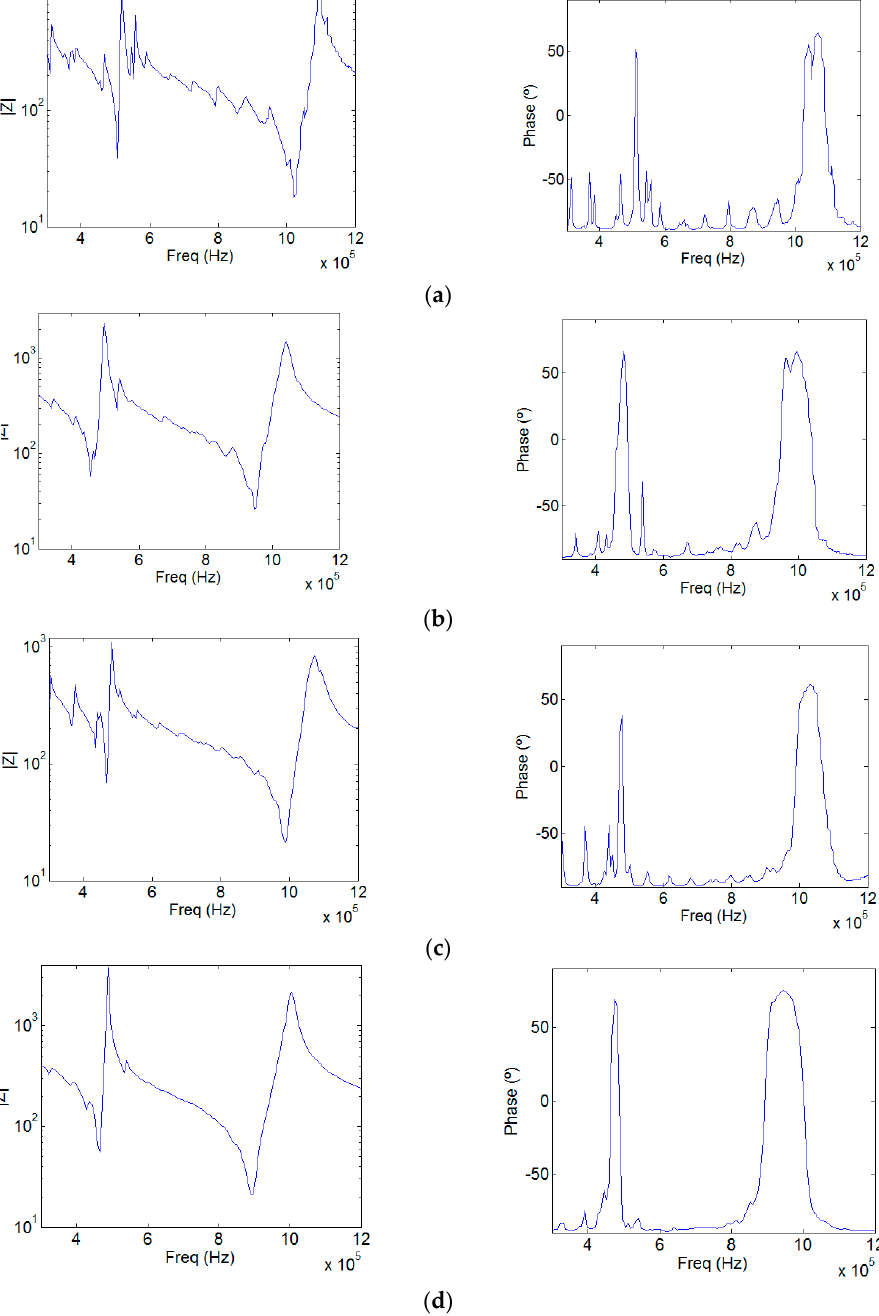
Figure 2. Calculated input electrical impedance. ( a ) Model 1 impedance module in logarithmic scale and phase. The same for Model 2 ( b ), Model 3 ( c ) and Model 4 ( d ).